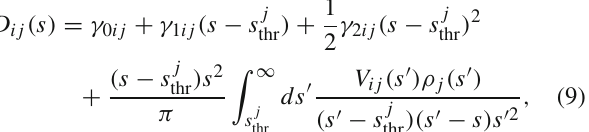
the threshold and that from the vector meson exchange is